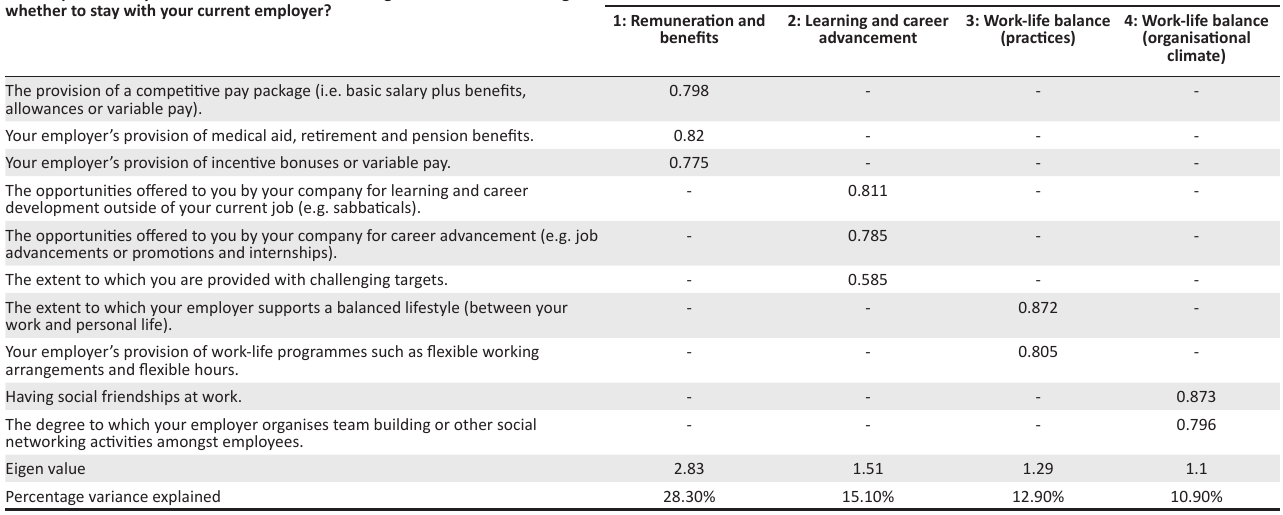
TABLE 3: Factor analysis for the total rewards scale.